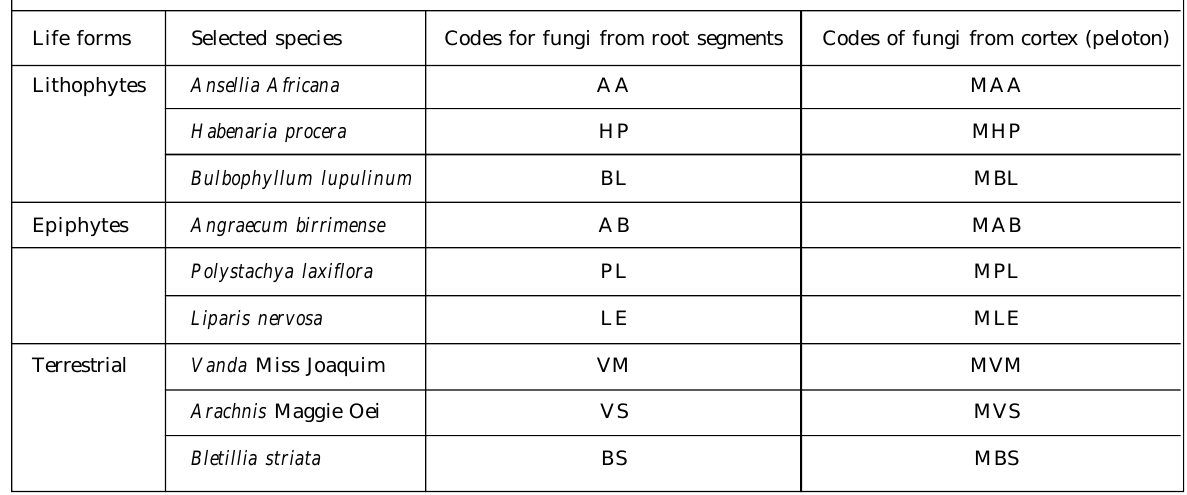
Table 1: Selected Orchid species and codes of fungal isolates Life forms Selected species Codes for fungi from root segments Codes of fungi from cortex